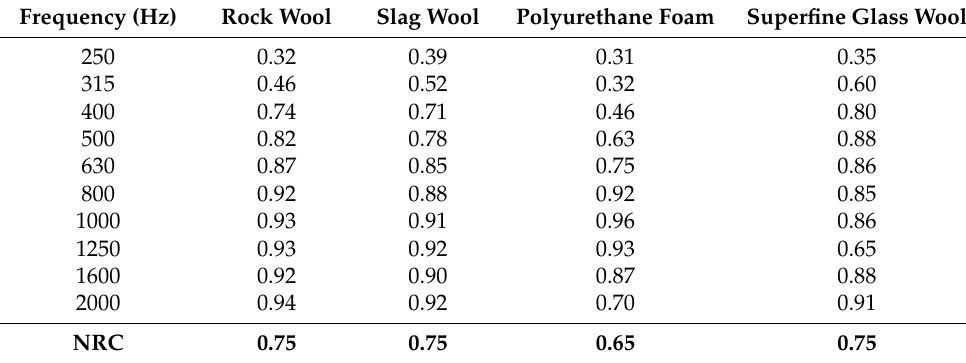
Table 1. Sound absorption coefficients and noise reduction coefficients of different sound absorption materials